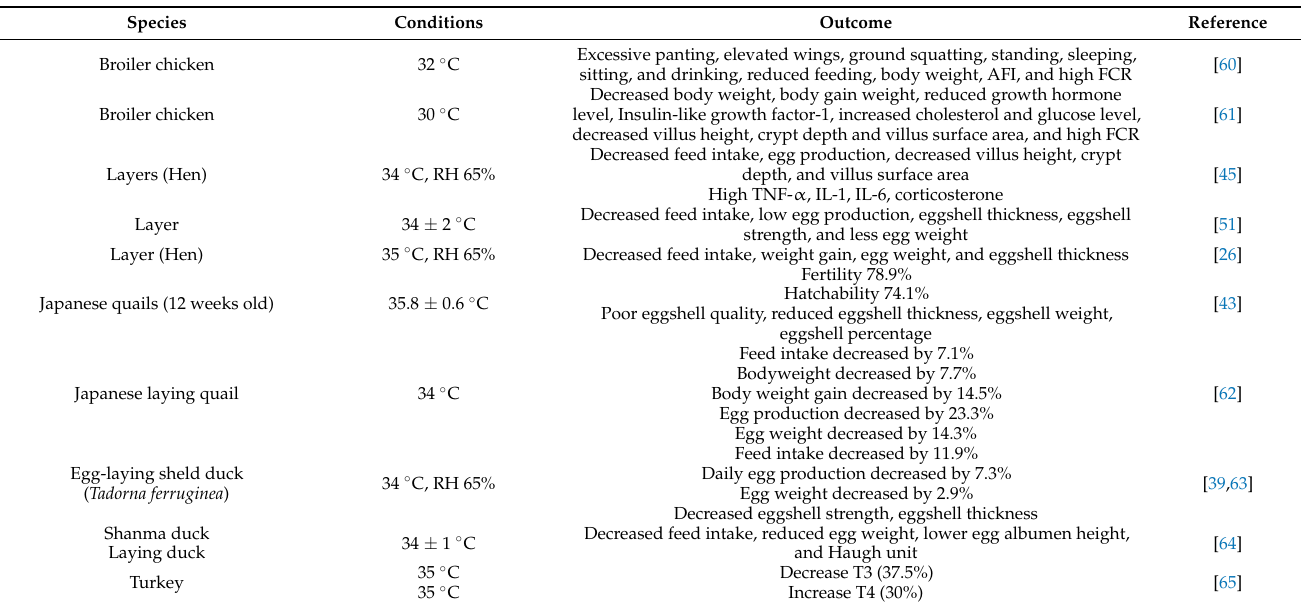
Table 1. Effect of heat stress on poultry